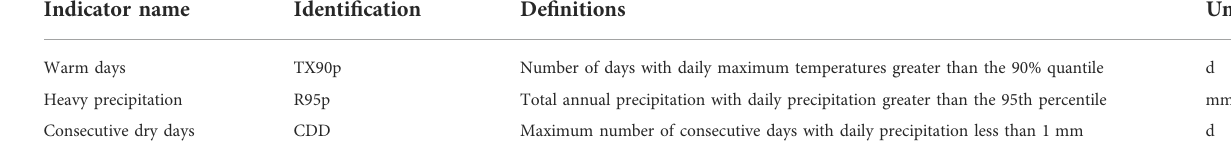
TABLE 1 Evaluation system for constructing extreme weather indicators.